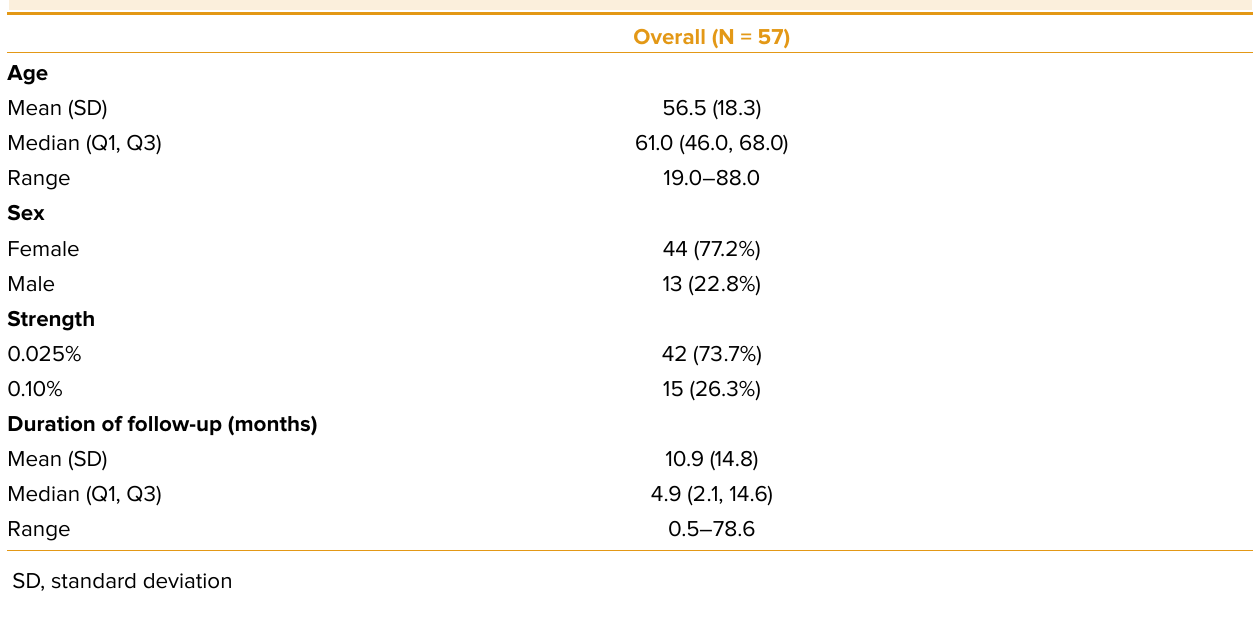
Table 1. Patients’ baseline characteristics.